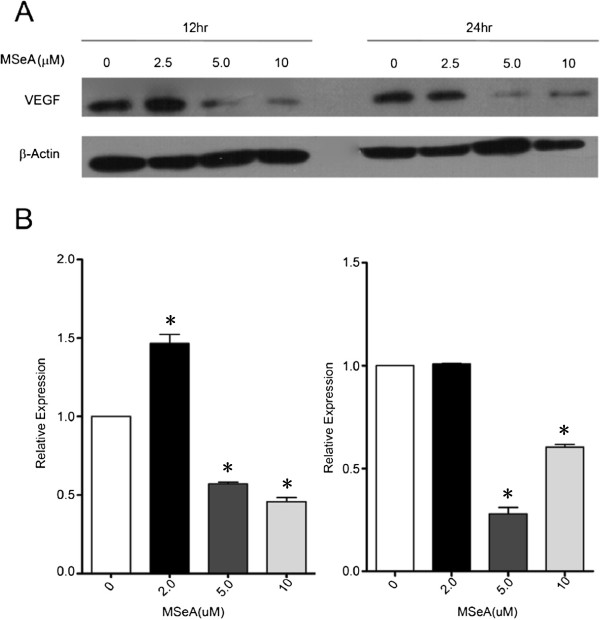
Western blot showing the level of vascular endothelial growth factor (VEGF) in MDA-MB-231 cells was dramatically reduced following the treatment of MSeA at 5 μM for 12 hrs. A higher MSeA concentration (10 μM) or longer treatment period (24 hrs) did not further inhibit the VEGF production. Commercial antihuman VEGF antibody (1: 200XD) was used to visualize the cellular VEGF protein band at the given MSeA concentrations and treatment time periods.